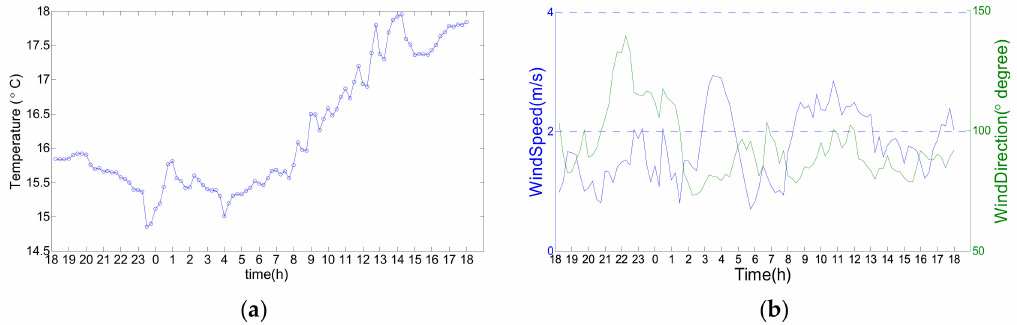
Figure 5. Ambient factors in the GNTVT Benchmark: ( a ) Temperature data; ( b ) Wind speed and wind direction data.